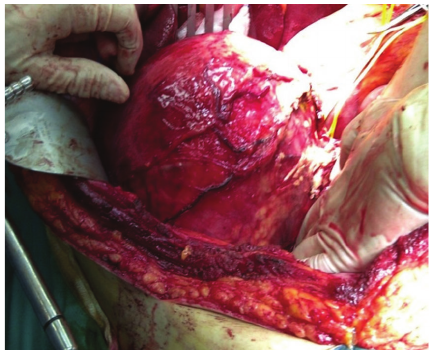
Figure 2: Patient’s MRI T1-weighted image with characteristic high- intensity signal from the mass.